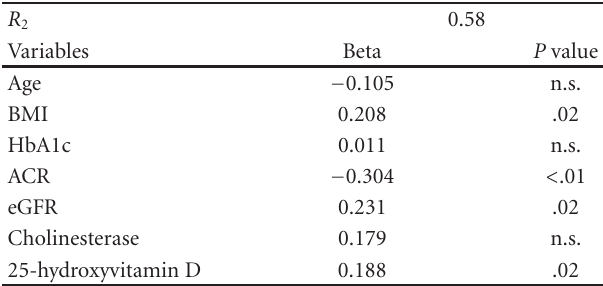
Table 3: Multiple regression analysis for hemoglobin concen- tration. Beta is the standardized partial regression coe ffi cient of multiple regression analysis. “n.s.” denotes “not